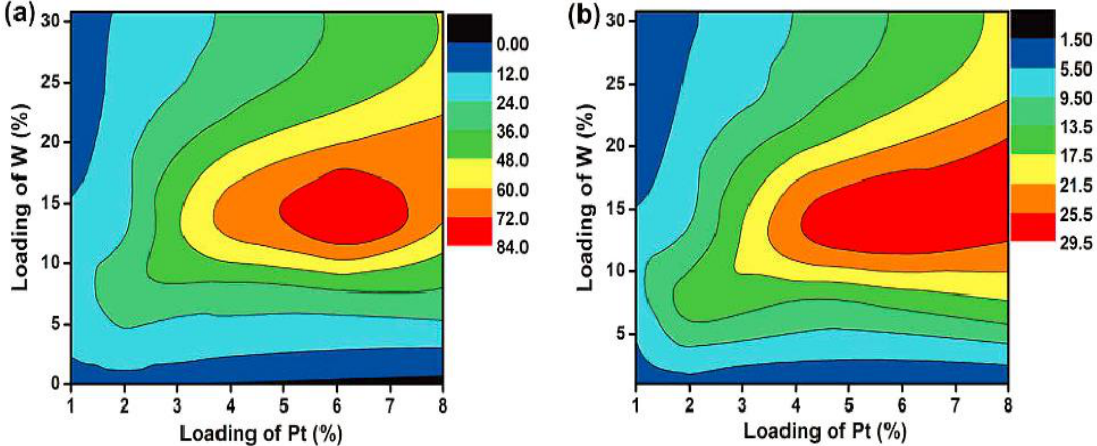
Figure 18. ( a ) The conversion of glycerol. ( b ) Yield to 1,3-PG as a function of Pt and W content in the Pt/WO x /Al 2 O 3 catalysts. Reproduced from [128] with permission from Wiley.